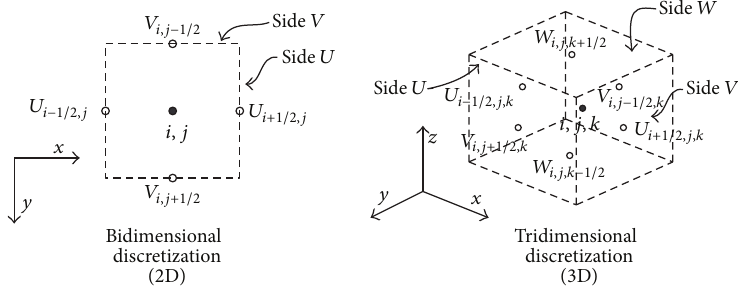
Figure 4: Control volume discretization in 2D and 3D.